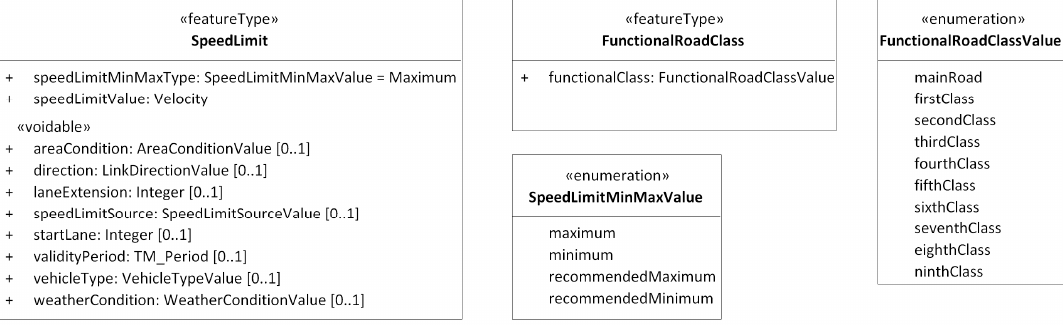
Figure 10. Extract of the INSPIRE TN Feature Catalogue Exchange GML file. <itsgml:Feature gml:id="vegvesen.no.nvdb.568225673_2"> <itsgml:typeName>FunctionalRoadClass</itsgml:typeName> <itsgml:validFrom>2018-08-31</itsgml:validFrom> <itsgml:beginLifespanVersion>2018-08-31T00:00:00</itsgml:beginLifespanVersion> <itsgml:featureTypeReference xlink:href="TransportNetworks.gml#TransportNetworks.FunctionalRoadClass"/> <itsgml:locationReference> … </itsgml:locationReference> <itsgml:locationReference> … </itsgml:locationReference> <itsgml:property> <itsgml:GenericFeatureProperty> <itsgml:memberName>functionalClass</itsgml:memberName> <itsgml:propertyStructure>listedValue</itsgml:propertyStructure> <itsgml:propertyTypeReference xlink:href="TransportNetworks.gml#TransportNetworks.FunctionalRoadClass.functionalClass"/> <itsgml:valueReference xlink:href="TransportNetworks.gml#TransportNetworks.FunctionalRoadClassValue.thirdClass"/> </itsgml:GenericFeatureProperty> </itsgml:property> </itsgml:Feature> Figure 11. Extract of the INSPIRE TN Feature Exchange GML file with an instance of the FunctionalRoadClass feature type.